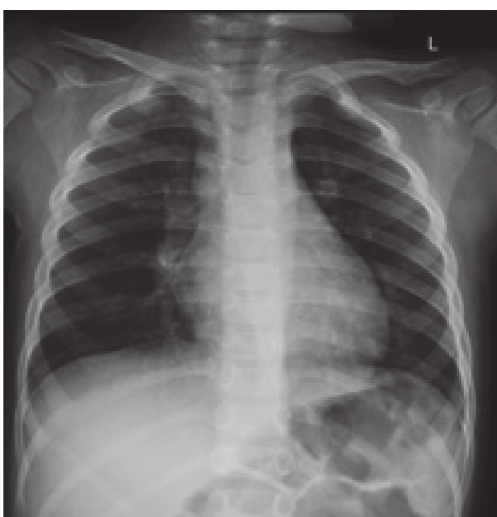
Figure 8: Follow-up chest radiograph obtained 6 months after hospitalization. Frontal CXR has no apparent